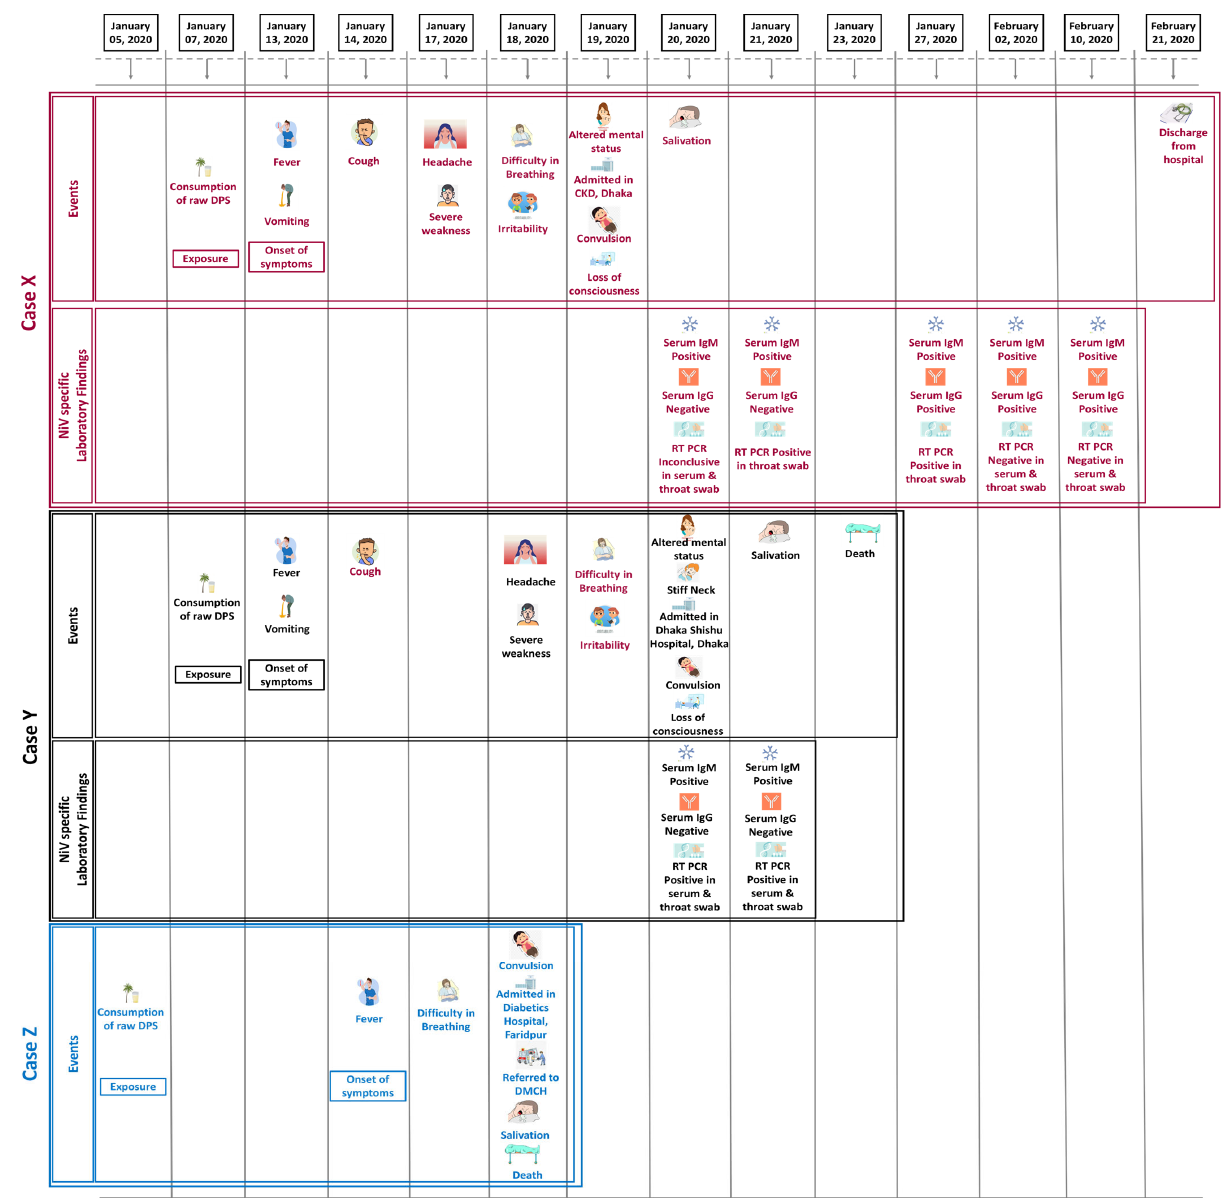
Figure 2. Findings from clinical and laboratory investigation according to the timeline.